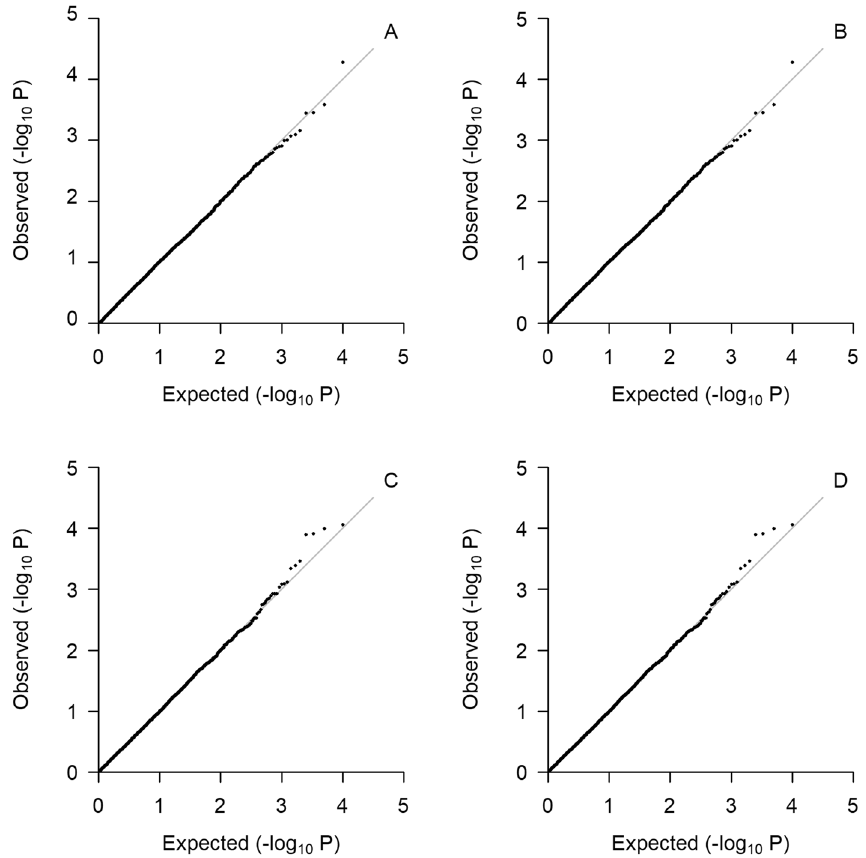
Figure 1. Quantile–quantile plots for the four test statistics under the null hypothesis. ( A ) Linear mixed model, ( B ) variance component model, ( C ) linear regression, ( D ) Chi-square